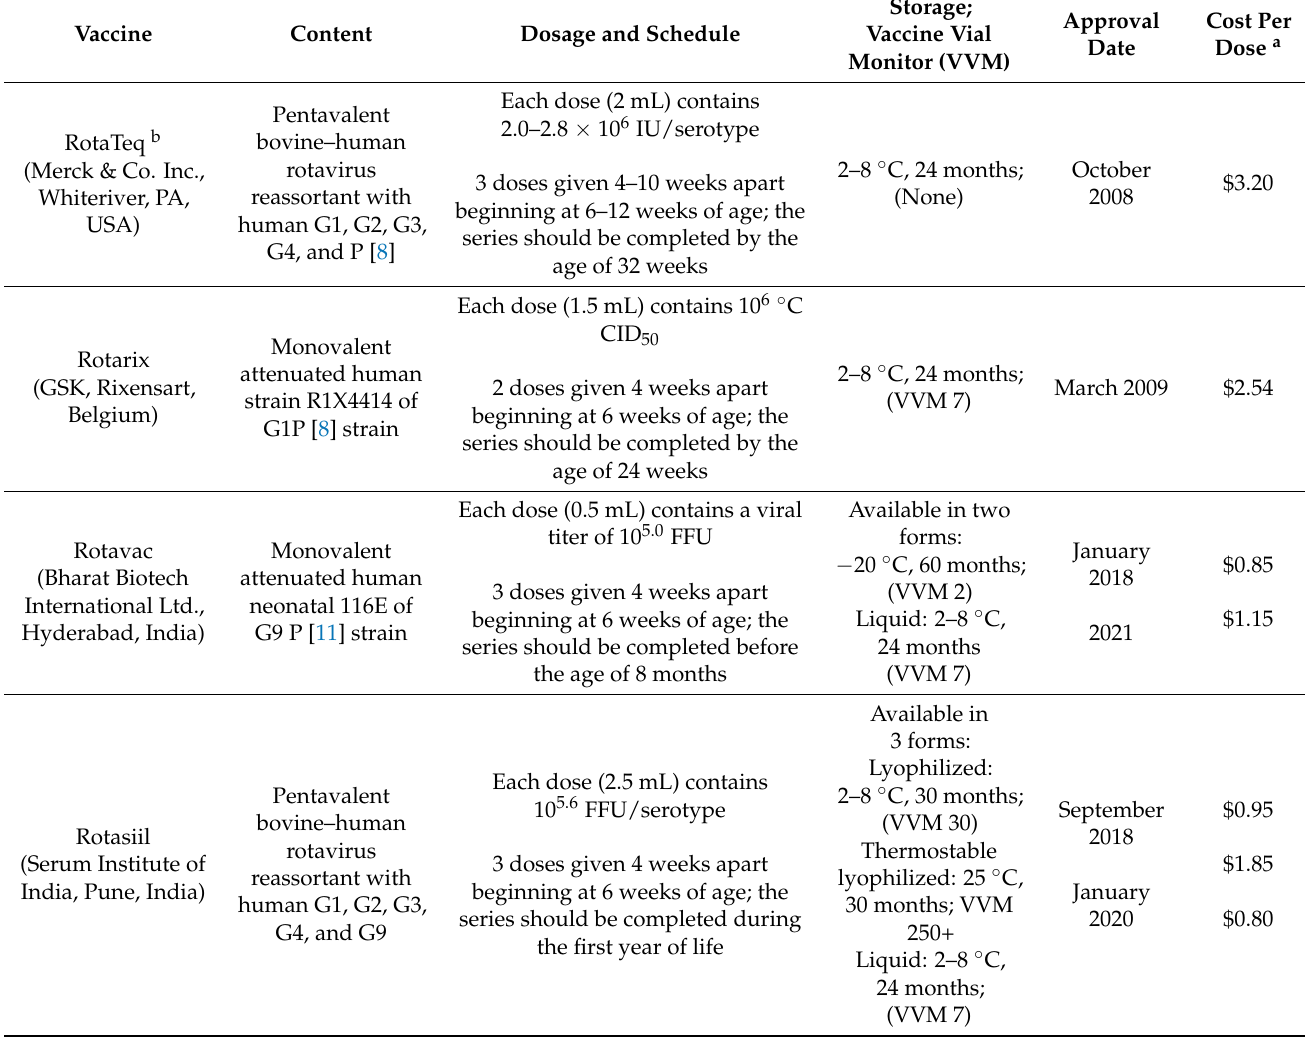
Table 1. WHO-approved rotavirus vaccines, January